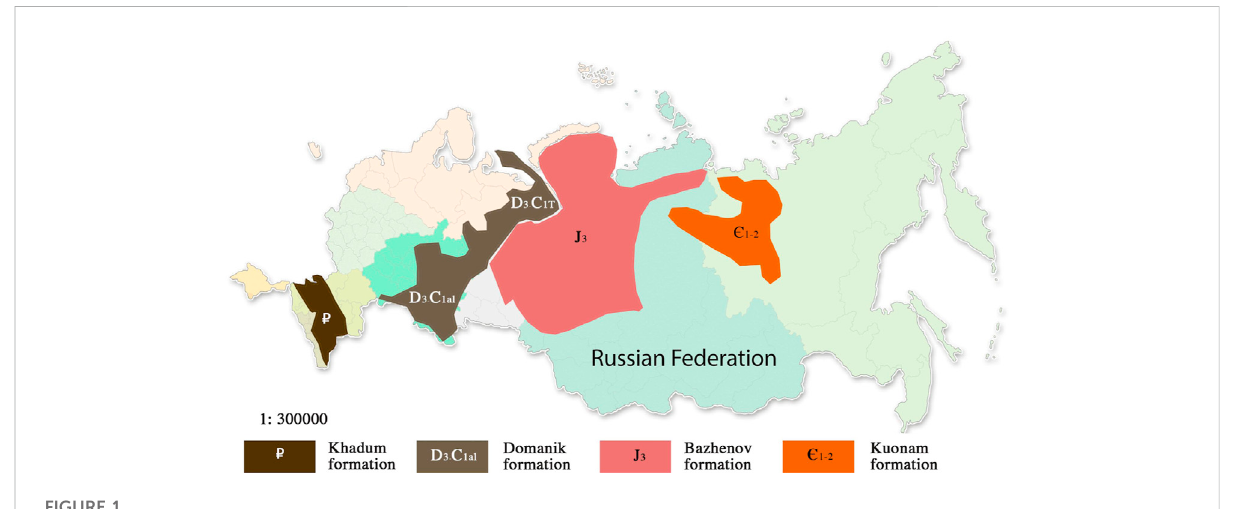
FIGURE 1 The main regions of development of high-carbon formations in